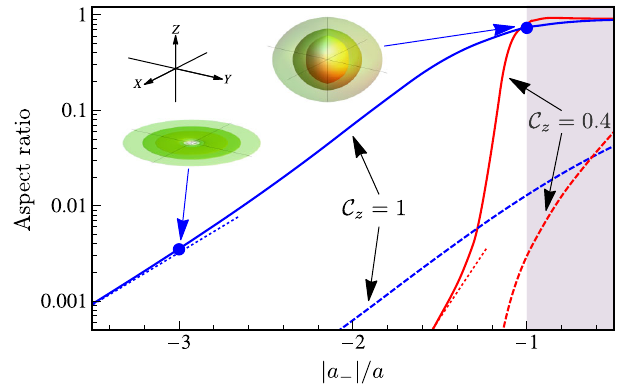
FIG. 1. Shape of the trimers under confinement: The aspect ratio 2 h Z 2 i = h ρ 2 i for the two deepest trimers is shown as a function of the interaction for two different confinement strengths C . Here, ρ is the separation of an atom and a pair in the x - y plane, z and Z is the separation in the confined direction (see the main text). The deepest trimer (solid lines) only exists in 3D for j a j =a ≥ − 1 , as depicted by the shaded region. Here, the aspect − ratio is close to 1, indicating that the trimer wave function resembles the 3D Efimov state. Outside the trimer ’ s regime of existence in 3D, the aspect ratio quickly decreases, indicating that the trimer spreads out in the 2D plane. The change in aspect ratio as a crosses a − is more gradual for the stronger confinement because of a stronger coupling between trimers of a 2D and 3D character. The deepest trimer eventually approaches the 2D asymptotic limit (dotted lines; see Appendix D). A similar picture emerges for the first excited trimer (dashed lines), but the aspect ratio here is much smaller than 1 even away from the 2D limit. The shape of the deepest trimer is illustrated in the insets, which show surface density plots of the squared wave function (see the main text) evaluated at the points marked by filled